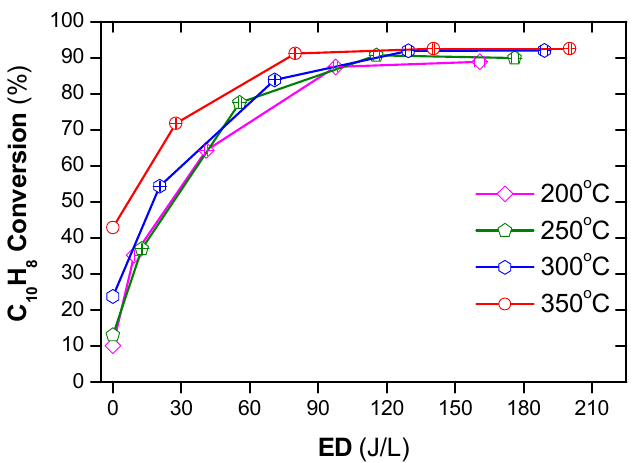
Figure 5. Conversion of naphthalene under temperature from 200 to 350 °C under various ED (energy density) (total flow rate of 2 L/min including: 48 ppm naphthalene, 300 ppm NO, 3.7% H 2 O, 10% O 2 , and N 2 as balance). Reprinted from Reference [2], 2019, MDPI